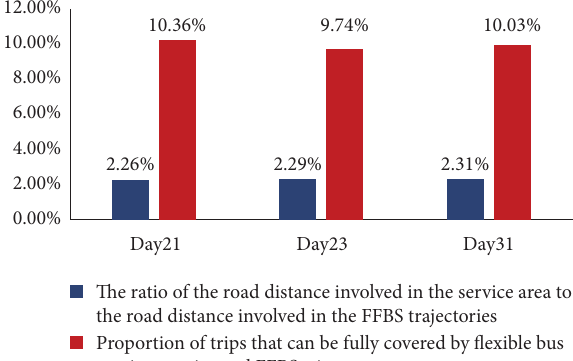
Figure 10: Planning efect of fexible bus service during 8:00 to 8:30.